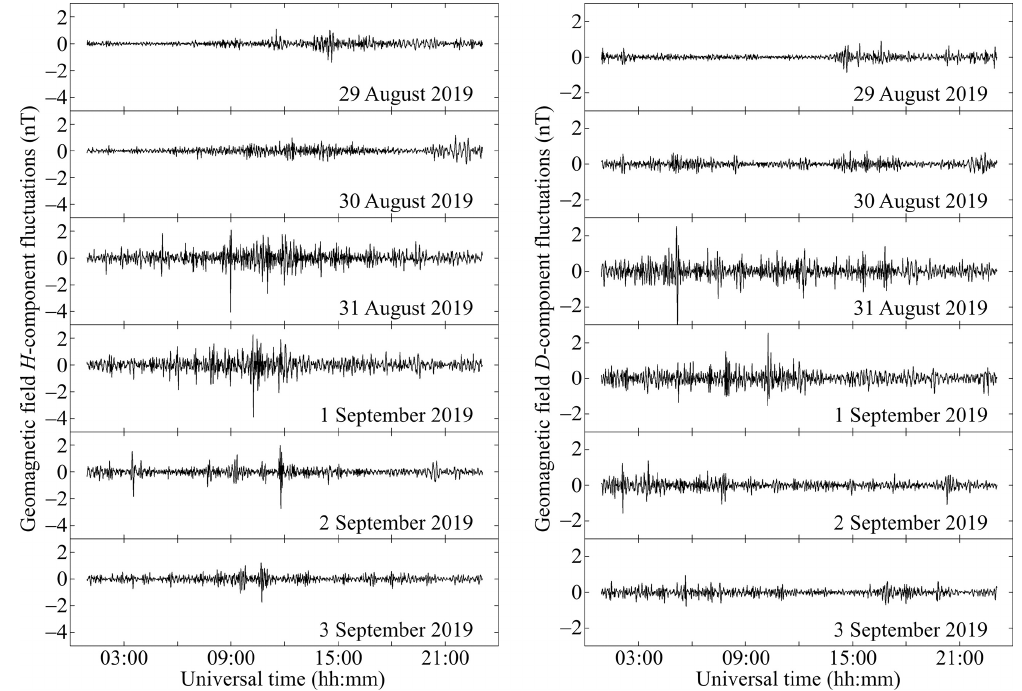
Figure 4. Magnetic field variations at the V. N. Karazin Kharkiv National University Magnetometer